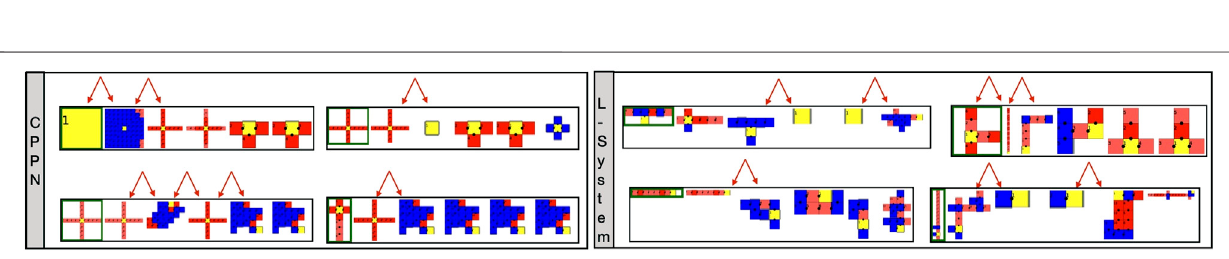
Frontiers in Robotics and AI |